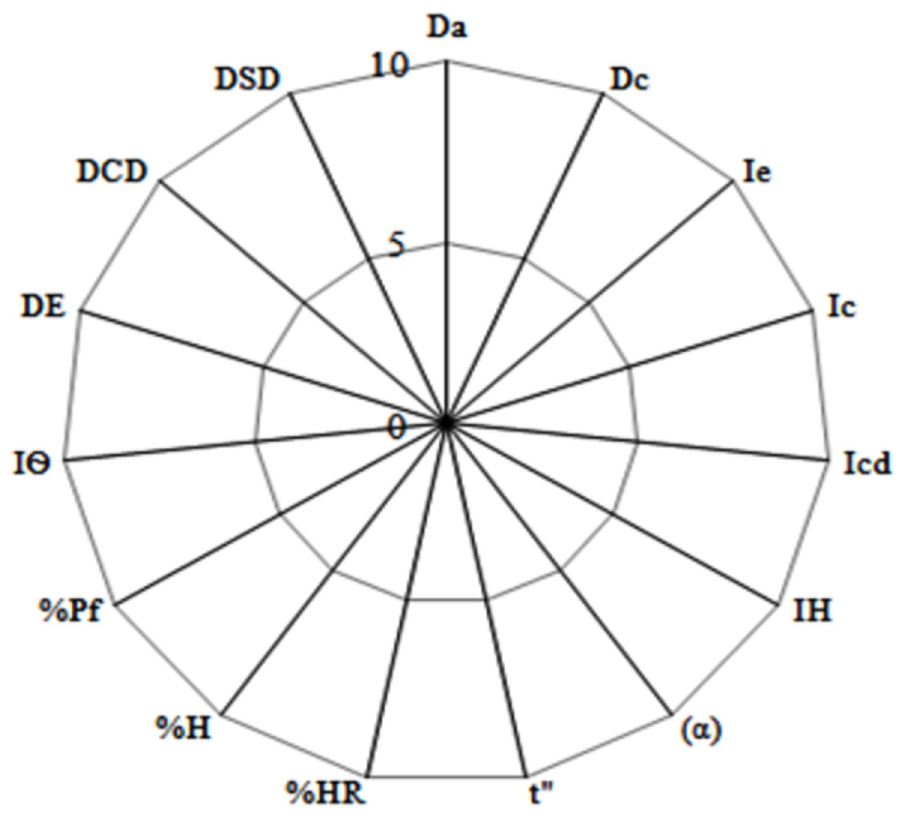
Fig 1. Blank SeDeM-ODT diagram presenting all the basic parameters included in the characterization. Maximum value of “r” is 10, with 5 as lower acceptable limit. Any value above 5 and close to 10 will show better results for the said